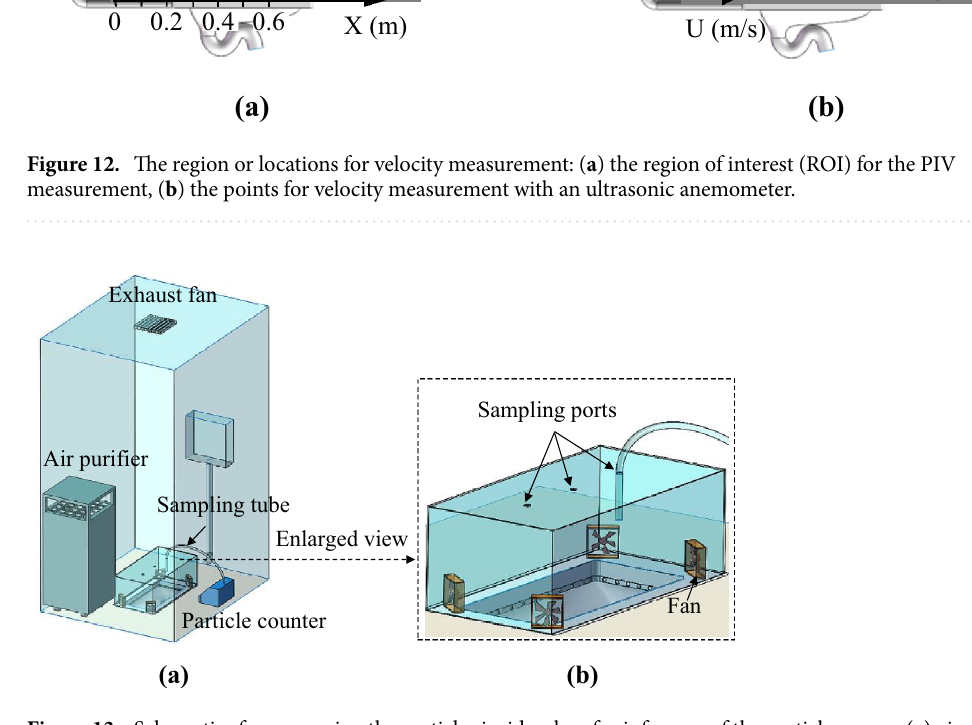
Figure 13. Schematics for measuring the particles inside a box for inference of the particle source: ( a ) view of the whole lavatory, ( b ) enlarged view of the box for particle